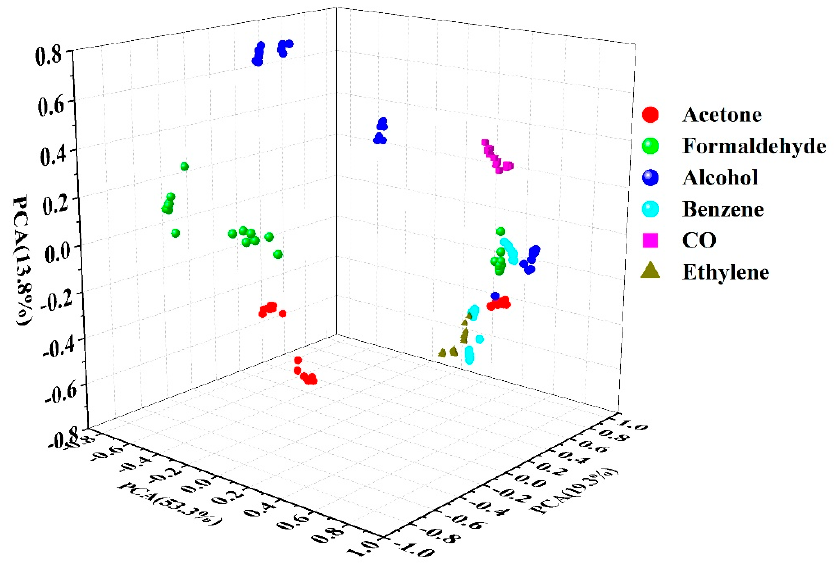
Figure 9. The principal component analysis (PCA) score plots of the sensing films.